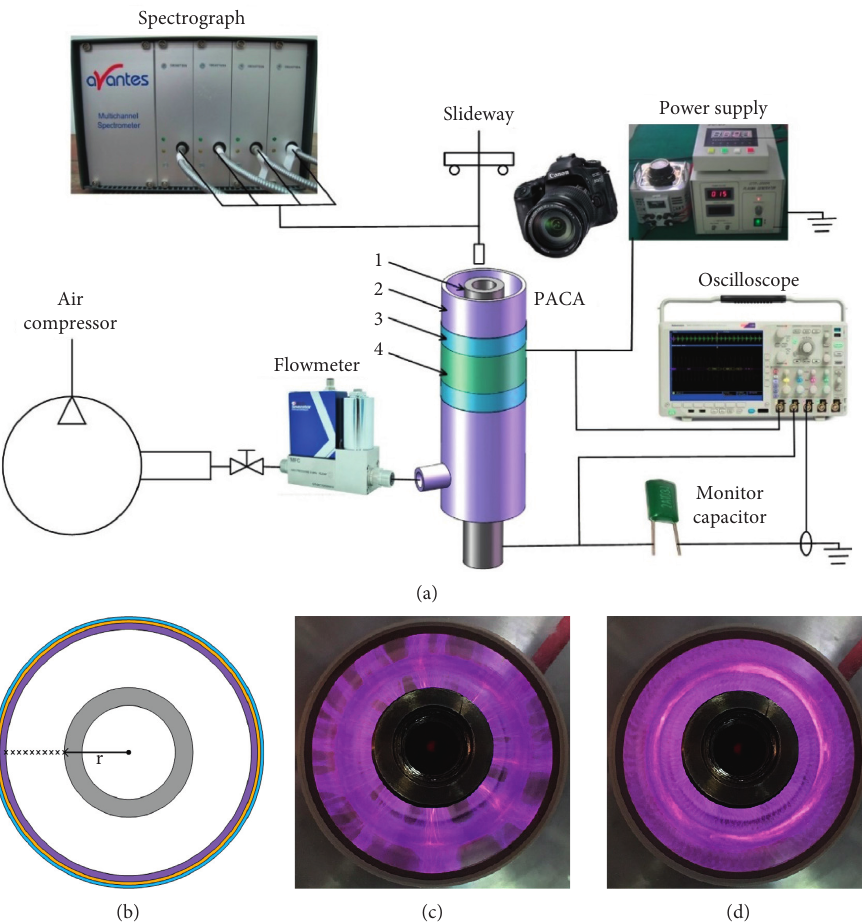
Figure 1: (a) Schematic of the experimental system, 1-inner electrode, 2-quartz glass tube, 3-copper foil electrode, and 4-five Kapton layers; (b) the top view of the coaxial DBD-PACA; (c) the discharge diagram without swirler; and (d) discharge diagram with